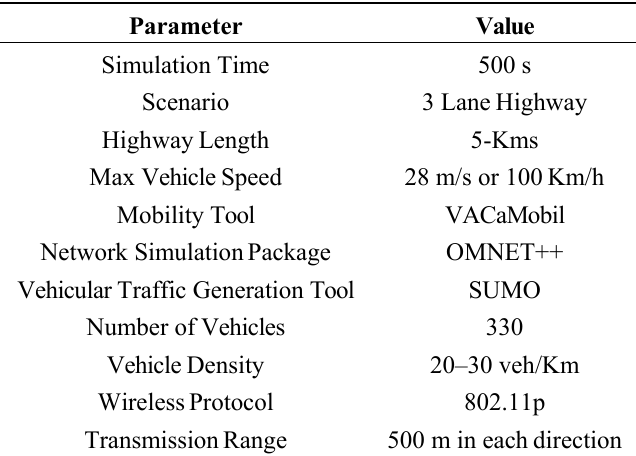
Table 3. Simulation parameters for C-DAC